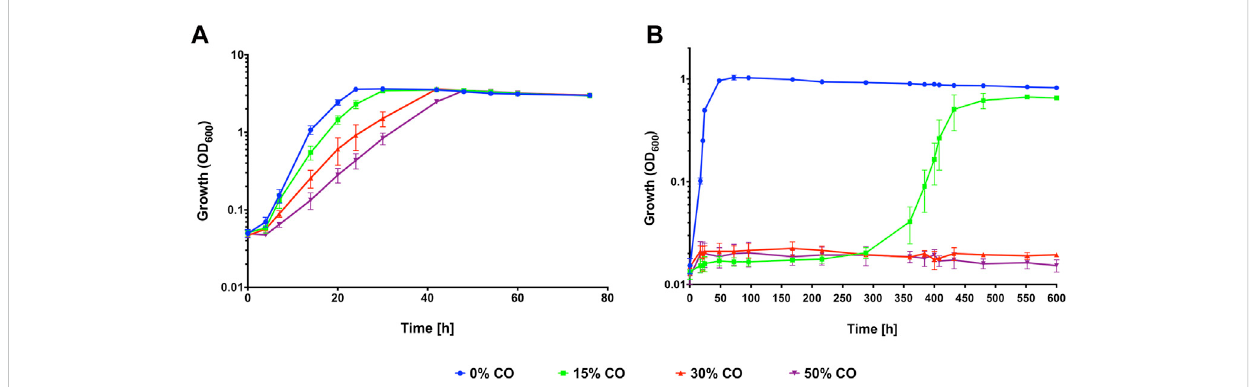
FIGURE 1 C. necator H16 heterotrophic growth (A) or autotrophic growth (B) with increasing concentrations of CO. C. necator was grown at 30 ° C in (A) 20 mL F-MM contained in 150 mL serum bottles under a 2 bar atm of 50% N 2 /50% air (v/v) (blue circles), 15% CO/35% N 2 /50% air (v/v) (green squares), 30% CO/20% N 2 /50% air (v/v) (red triangles) and 50% CO/50% air (v/v) (purple inverted triangles), respectively and in (B) 25 mL MM contained in 250 mL serum bottles under a 2.4 bar atm of 0% CO/80% H 2 /10% CO 2 /10% air (v/v) (blue circles); 15% CO/65% H 2 /10% CO 2 /10% air (v/v) (green squares); 30% CO/50% H 2 /10% CO 2 /10% air (v/v) (red triangles) and 50% CO/30% H 2 /10% CO 2 /10% air (v/v) (purple inverted triangles), respectively. Error bars represent the standard deviation of the mean for three independent replicates.